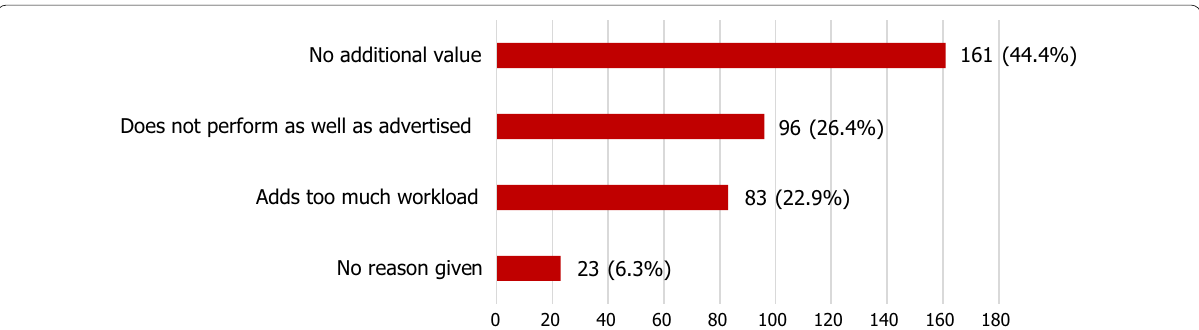
Fig. 2 Reasons given by 363 of all 690 participants of the survey (regardless of their experience with AI-based algorithms in clinical workflow) for not intending to acquire a certified AI-based algorithm for their clinical